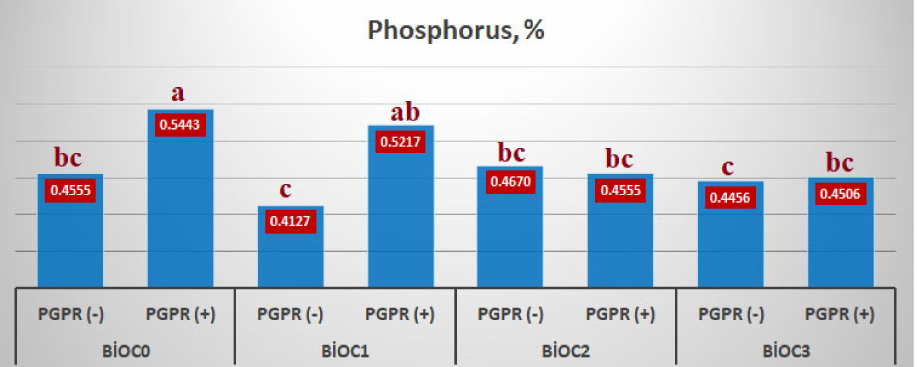
Figure 4. Effect of BxP interaction on phosphorus content of einkorn wheat: PGPR(+): Inoculation; PGPR(-): Non-inoculation; BioC 0 : 0% biochar; BioC 1 : 2.5% biochar; BioC 2 : 5% biochar; BioC 3 : 10% biochar; Phosphorus LSD(0.05) : 0.0657. Means followed by different letters are statistically different from each other according to Duncan’s Multiple Range test at p ≤ 0.05.